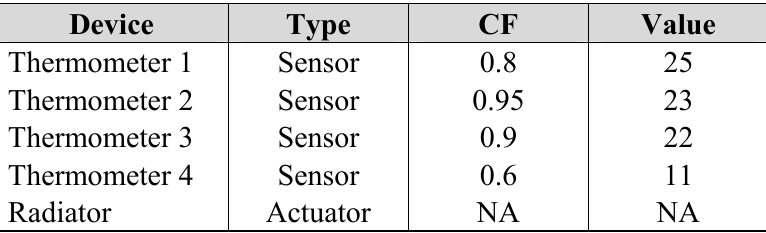
Table 2. Devices present in scenario